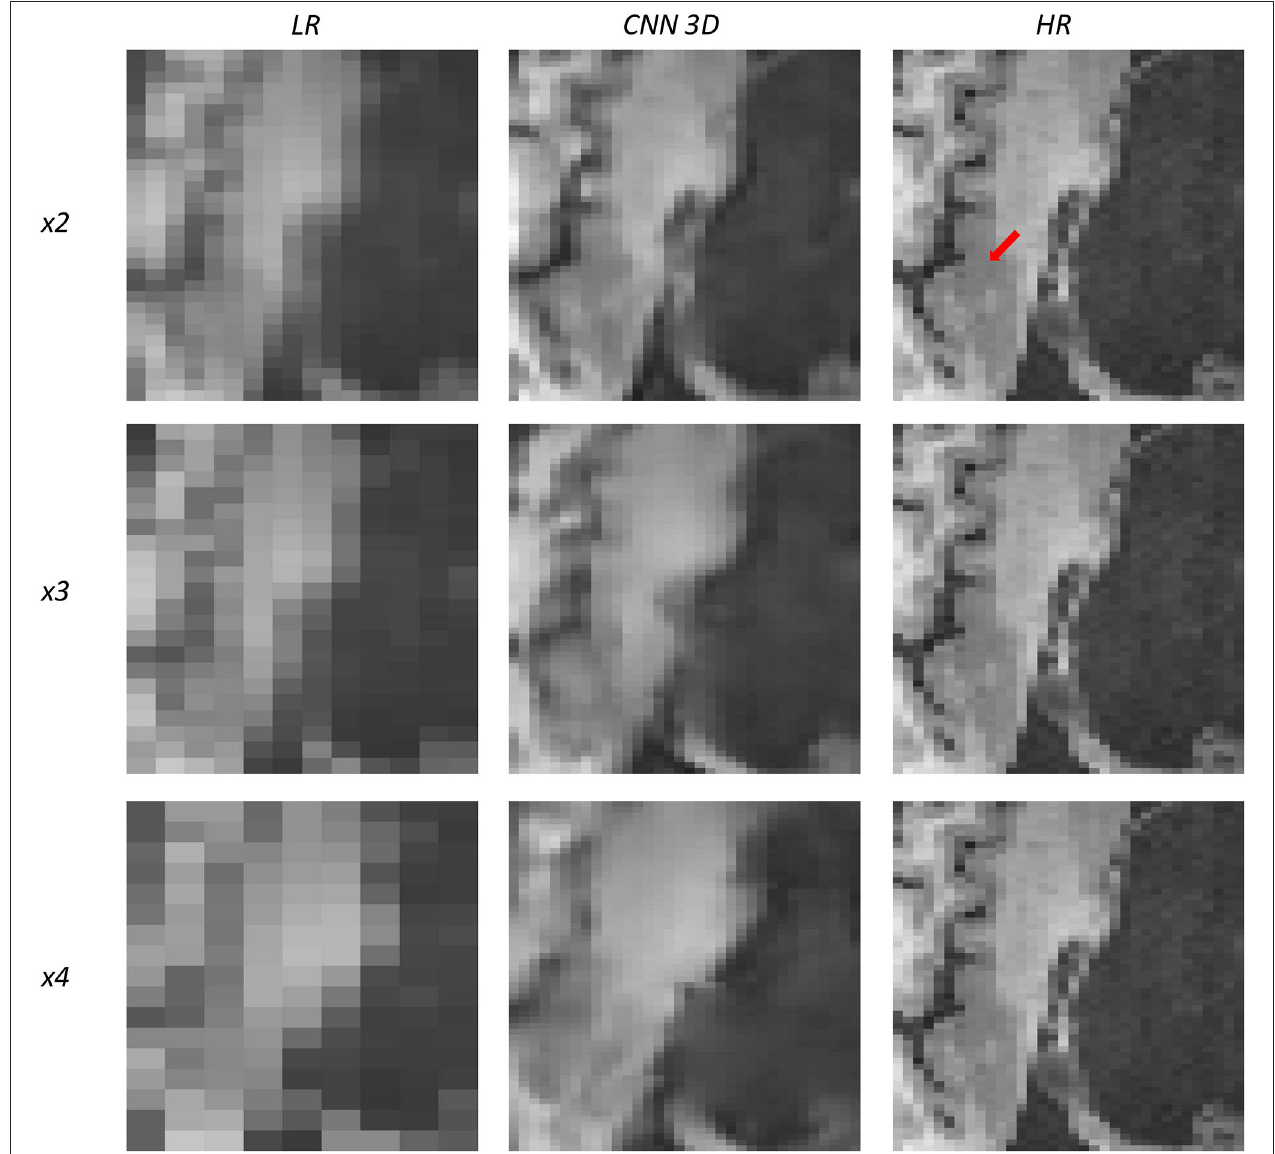
FIGURE 11 | Results of both CNN methods on three scaling factors of super-resolution on images of a patient with dysplasia. A specific region of a slice is shown, with the red arrow pointing to a lesion.